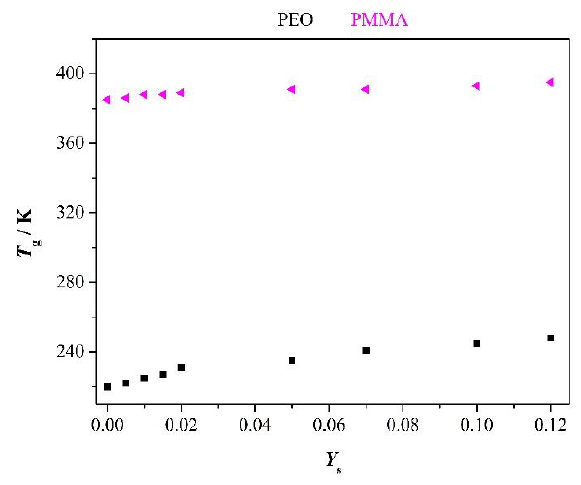
Figure 1. Glass transition temperature of the two parent polymers versus added salt content Y S